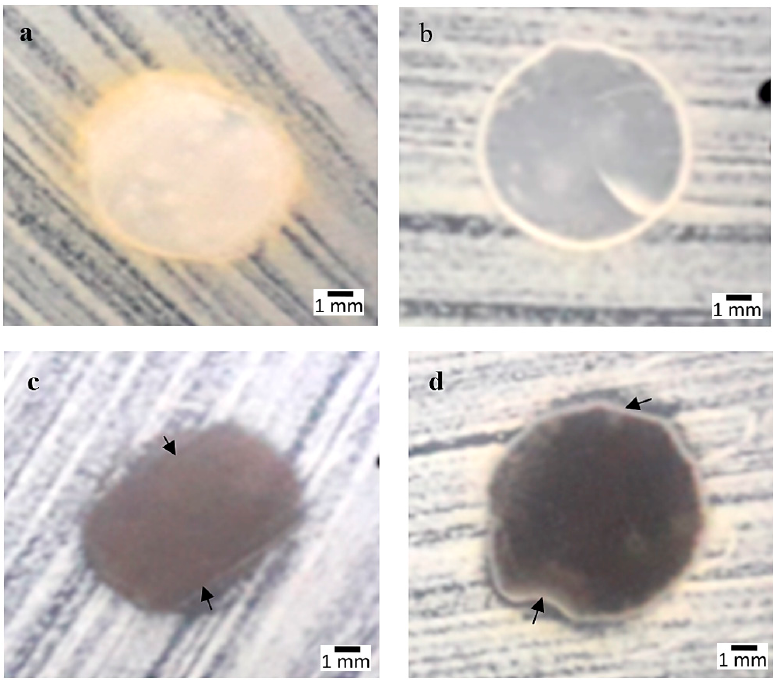
Figure 2. Staphylococcus aureus strain: ( a ) Sugar palm starch (SPS), ( b ) 0 wt%, ( c ) 3 wt%, ( d ) 4 wt% compositions. Polymers 2020 , 12 , x FOR PEER REVIEW The measurement of the inhibited area measured in 3 wt% AgNPs in S. aureus was 0.1 ± 0.00 mm and for 4 wt% it was 0.5 ± 0.00 mm. The SPS and 0 wt% samples showed yellow precipitation on the surface, which might be caused from the building up of bacterial colonies due to the fewer silver ions released. The walls of Staphylococcus aureus (+ve) were thicker compared to those of Escherichia coli ( − ve) and Salmonella cholerasuis ( − ve), thus the penetration of silver ion was less compared to negative types of microbes. Gram-positive bacteria are composed of a thick peptidoglycan (20–80 nm) layer consisting of linear polysaccharide chains cross linked by short peptides, forming a complex structure that makes it more difficult for silver ions to penetrate into Gram-positive bacteria [65]. Referring to Figure 3, Salmonella cholerasuis produced a large area of inhibition with a similar percentage value to E. coli at a higher percentage. SPS and 0 wt% were observed to appear in a yellowish color and were similar for all types of microbes tested; meanwhile, 3 and 4 wt% produced a larger inhibited area around the circle. The average area of inhibition measured in 3 wt% tested with Salmonella was within 7.5 ± 0.288 mm and in 4 wt% this was increased to 8.0 ± 0.288 mm. Te average inhibition area for 4 wt% of E. coli and Salmonella were slightly higher compared to 3 wt% and not many differences were observed, as they were derived from the same negative types of microbes.